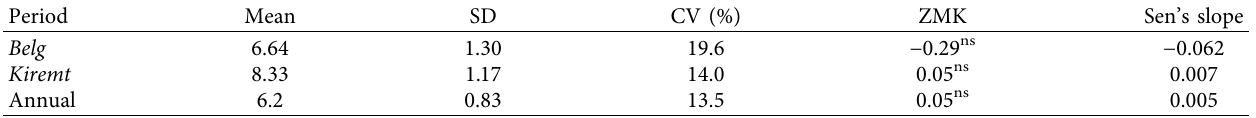
Table 5: Annual and seasonal minimum temperature trends in the study area